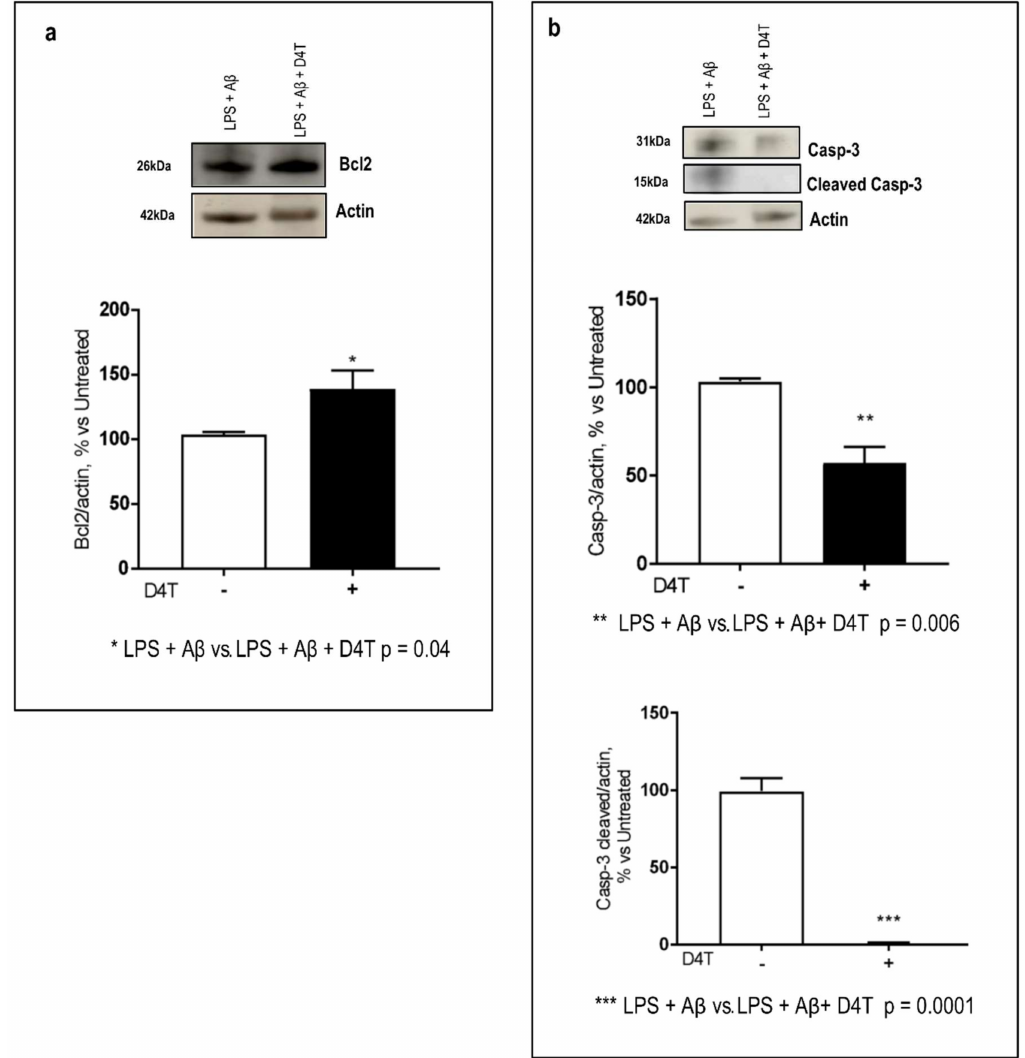
Figure 5. Caspase-3/cleaved-Caspase3 and Bcl2 production. Western blot analysis of Bcl2 (( a ) 26 KDa) and Caspase-3 (( b ) 31 KDa) and cleaved Caspase-3 (( b ) 15 KDa) were evaluated. Each result is expressed as a percentage of the ratio between each target and actin expression versus D4T-untreated cells. Statistical significance is shown as (*** p < 0.0001, ** p < 0.001, * p < 0.05). Representative blots from independent experiments are shown in the panels ( a , b